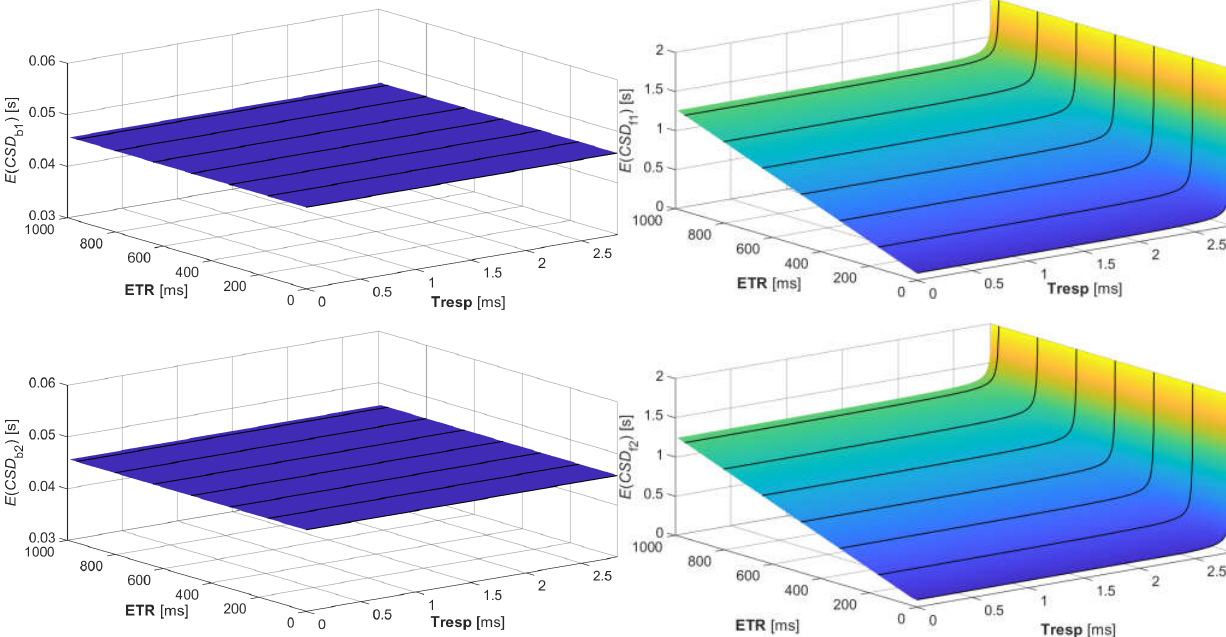
Figure 7. Selected results for data set 4 from Table 1.